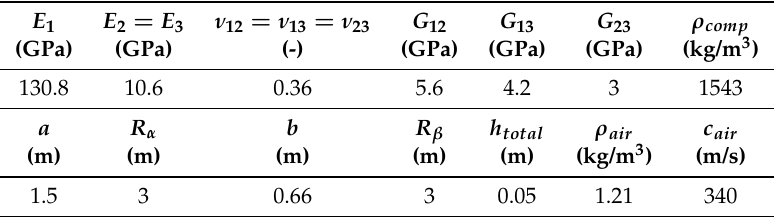
Table 3. Geometrical and material data for the composite shells.